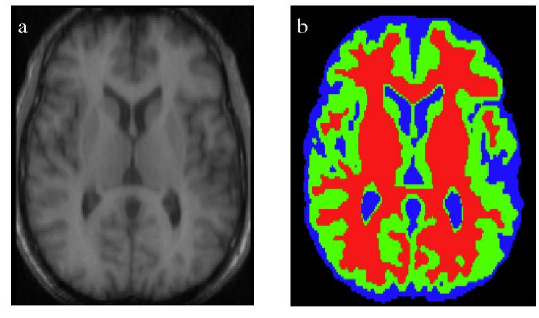
Figure 1. Medical image segmentation